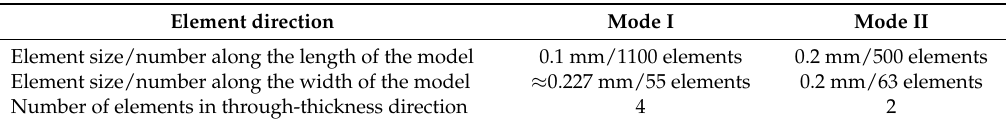
Table 2. Mesh density at which converged solution is obtained.